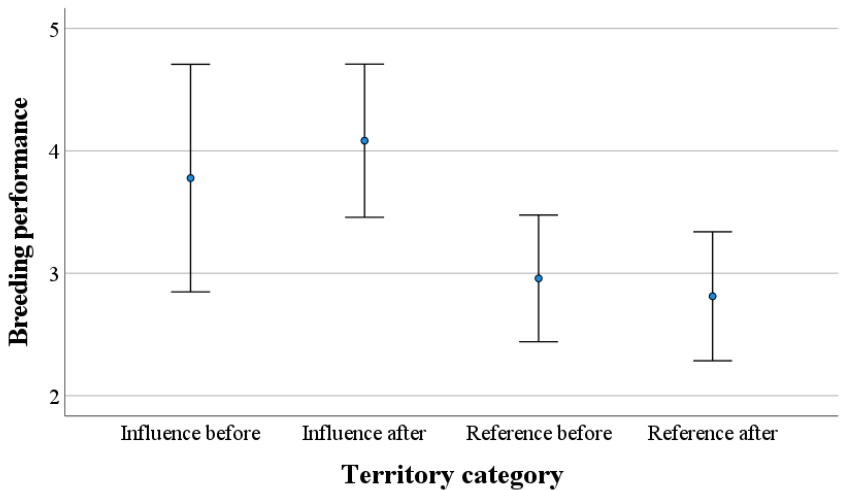
Figure 3. Breeding performance (score 1–6, see text) ± 2 SE for the 11 nests on Hitra and Frøya with at least one year with the production of young in the time period 2015–2021. The nests were within or outside an influenced area of 3 km from the closest wind turbine or power line before and after the disturbance started ( n = 3 nests), or in reference areas further away ( n = 8